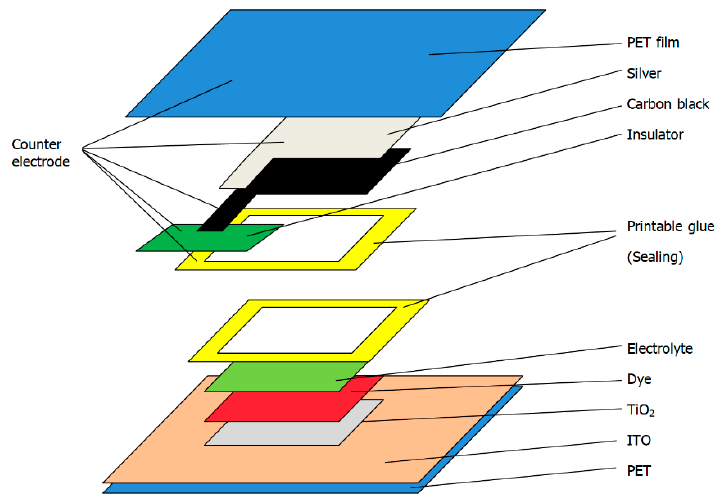
Figure 1. Structure of the flexible dye-sensitized solar cell.